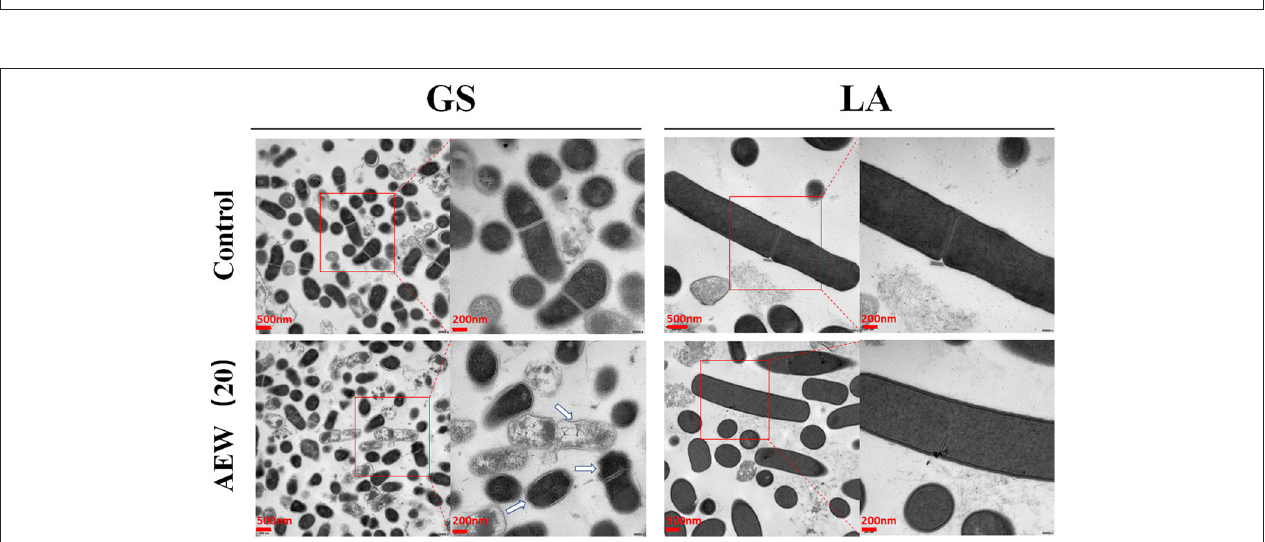
FIGURE 2 | Twenty ppm AEW induced structural damage to GS but had less effect on LA. The image showed the internal structure of GS and LA observed under a transmission electron microscope after 20 ppm AEW treatment. The arrow indicated the destruction of the inside of the bacteria.